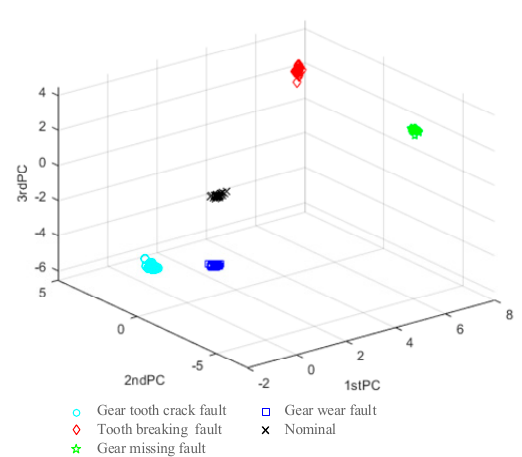
Figure 19. Clustering result of ICEEMD-time-frequency information entropy under variable conditions.